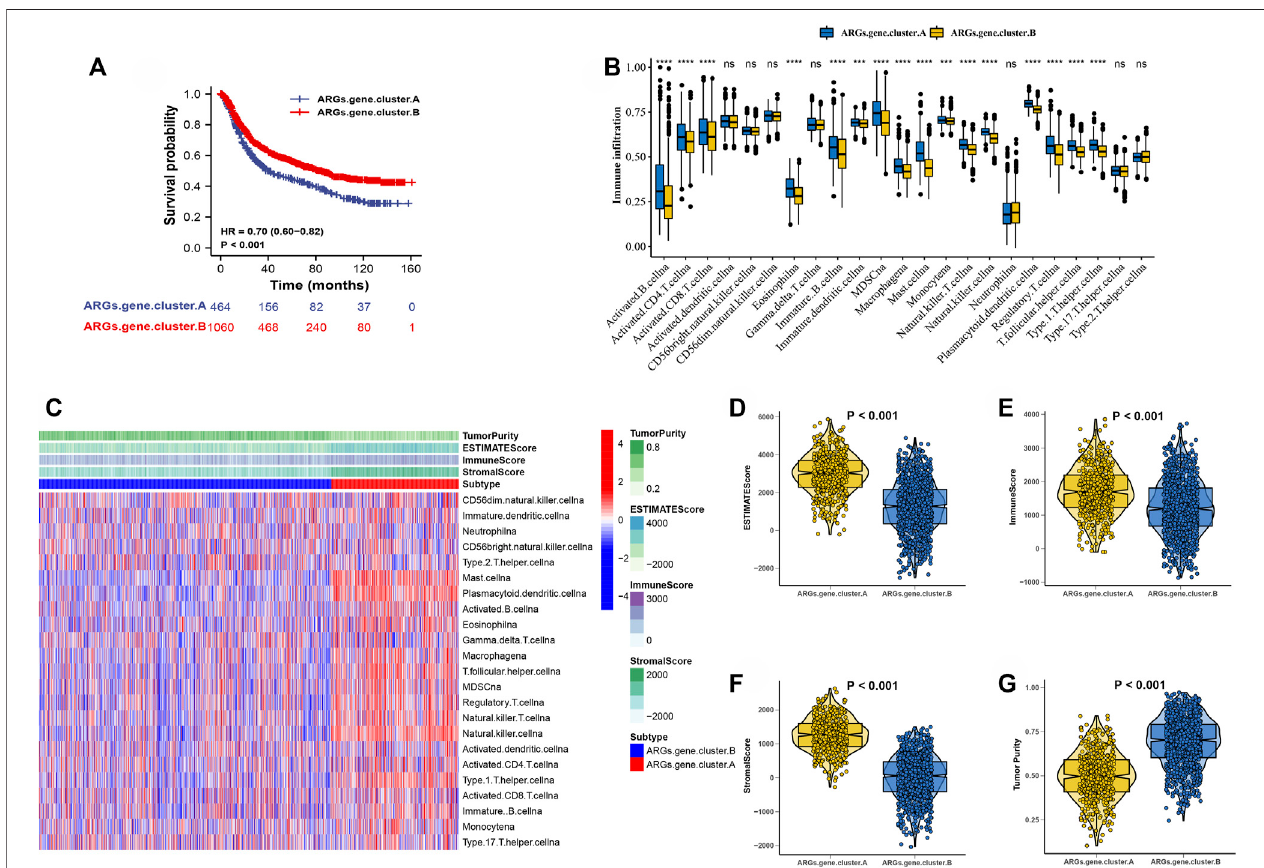
FIGURE 4 | Consensus clustering of 3,083 genes identi fi ed two clusters in GC. (A) Kaplan-Meier curve showed a signi fi cant difference between the two ARGs.gene.clusters. (B) The correlation of tumor microenvironment condition and ARGs.gene.clusters. (C) The abundance of each TME in fi ltrating cell in two ARGs.gene.clusters.The upper and lower ends of the boxes represented the interquartile range of values. The lines in the boxes represented median value, and black dots showed outliers. (D – G) The ESTIMATE score, stromal score, immune score, and tumor immunity levels in the ARGs.gene.clusters.A and ARGs.gene.clusters.B groups by using ESTIMATE algorithm. (* p < 0.05; ** p < 0.01; *** p < 0.001; **** p <